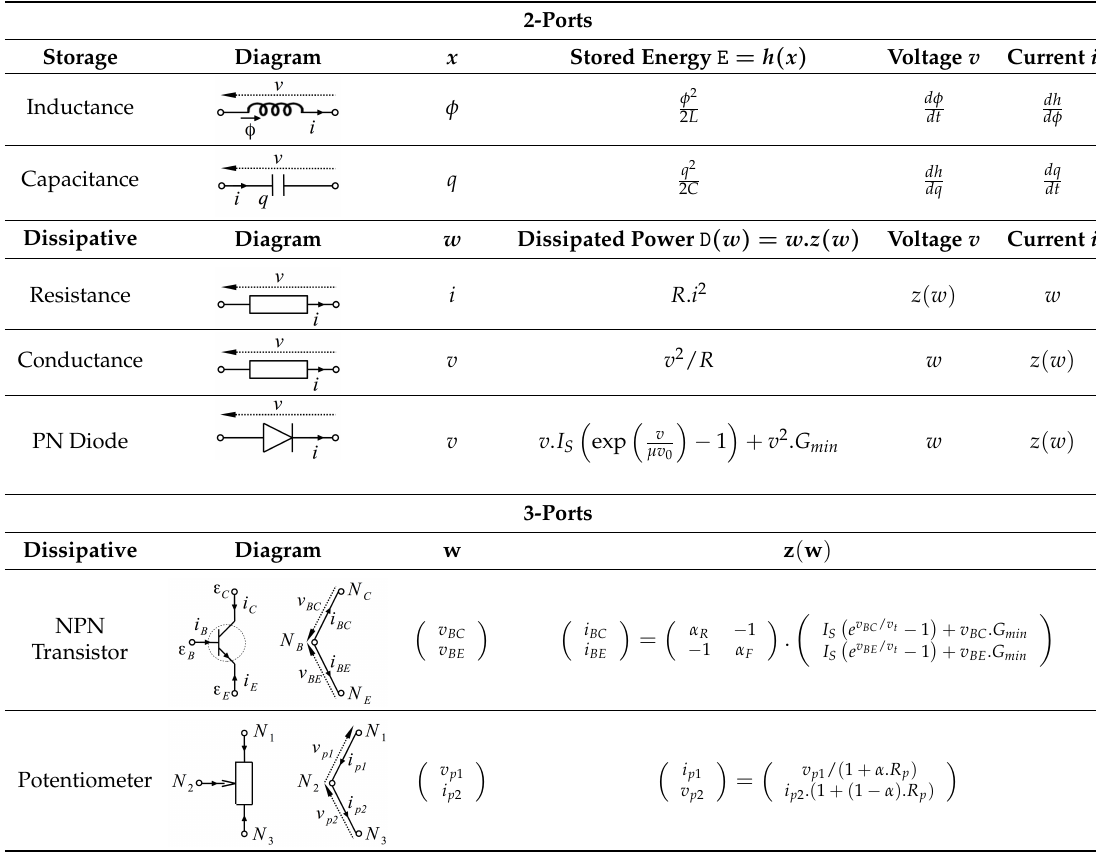
Table B1. Dictionary of elementary